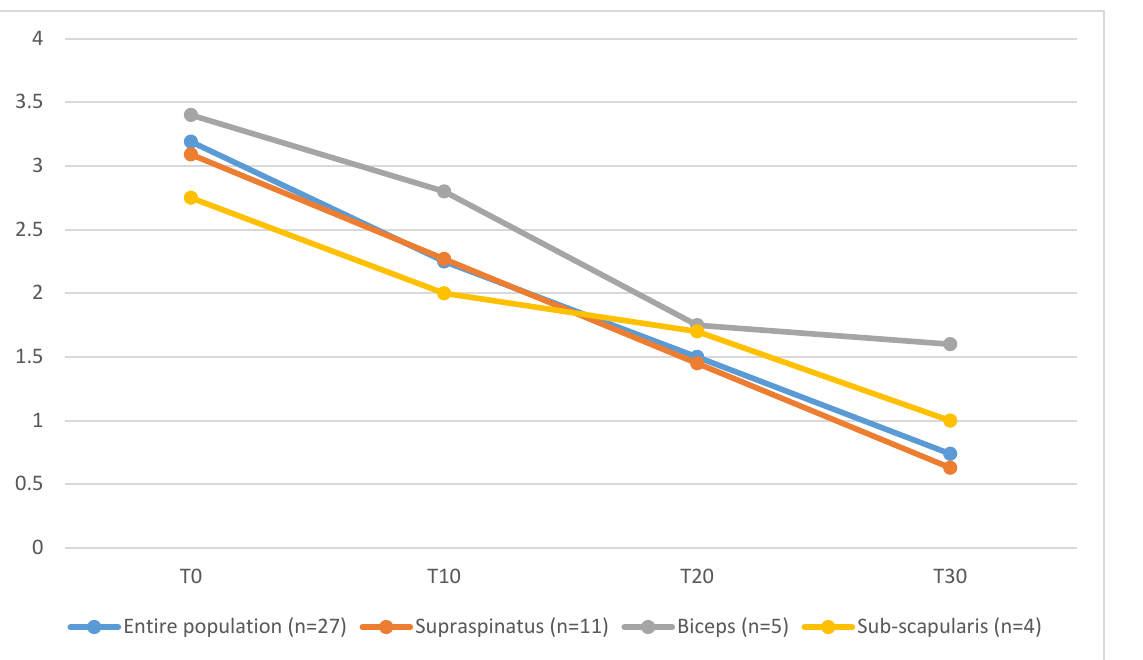
Figure 4. Mean lameness scores values of the entire population and divided into 3 sub-groups based on others concomitant lesions investigated during the arthroscopic evaluation are reported for each time frame. Blue line: values are reported for the entire population. Orange line: subjects affected by ST without any other concomitant lesions. Grey line: subjects affected by ST and biceps brachii lesions. Yellow line: subjects affected by ST and sub-scapularis tendon